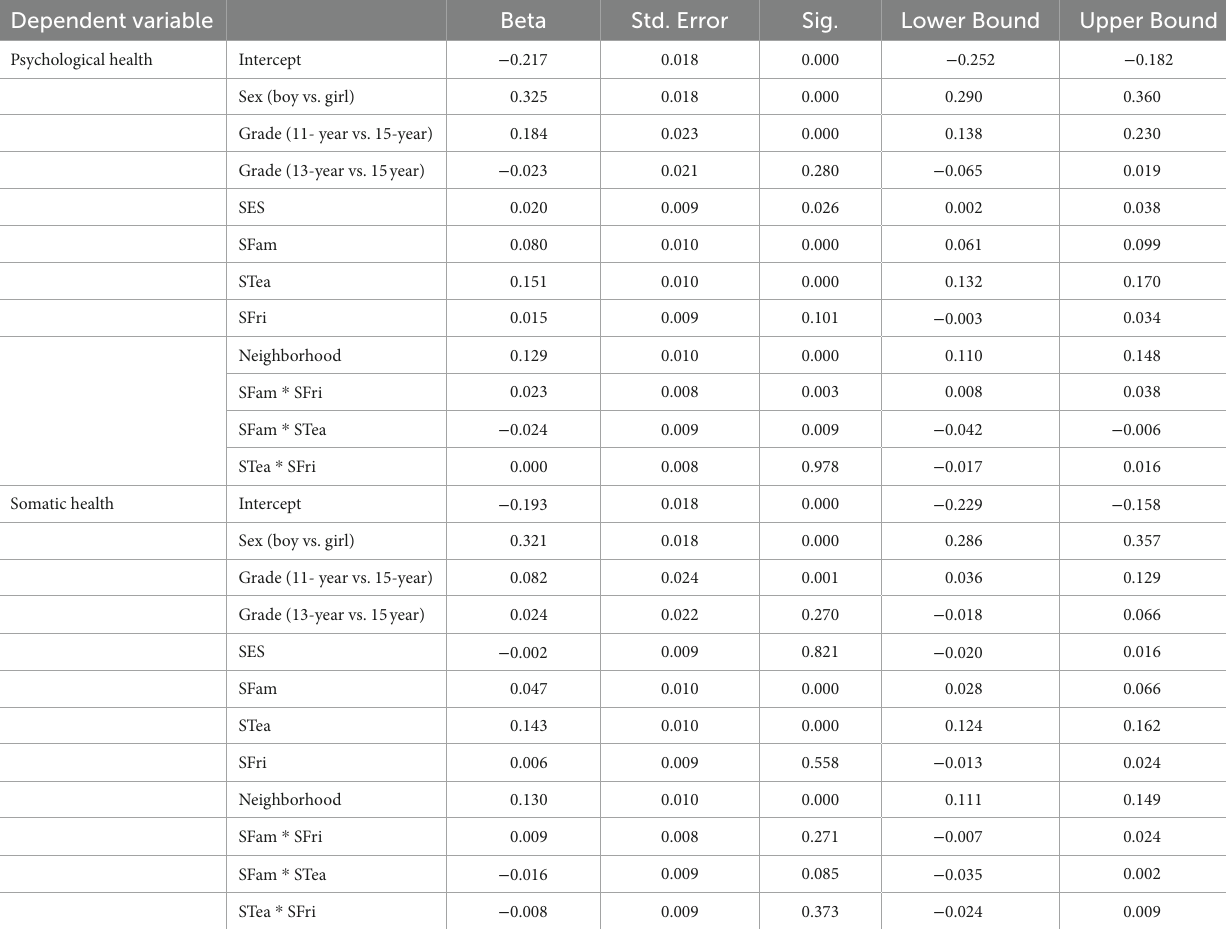
TABLE 4 The complete ecological model using a multilevel regression to investigate adolescents’ psychological/somatic health. Dependent